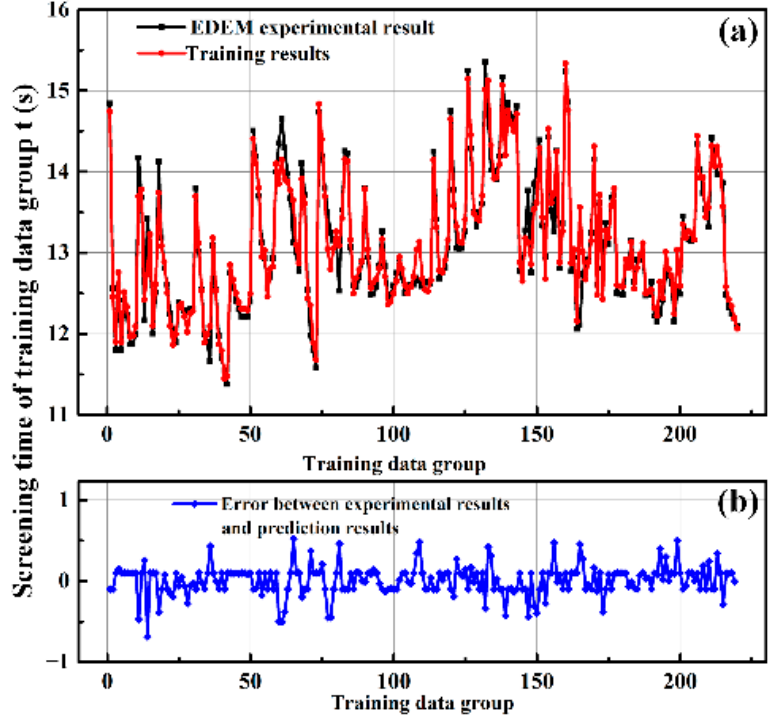
Figure 13. Comparison of screening time between the training and experiment. ( a ) training results, and ( b ) error results.